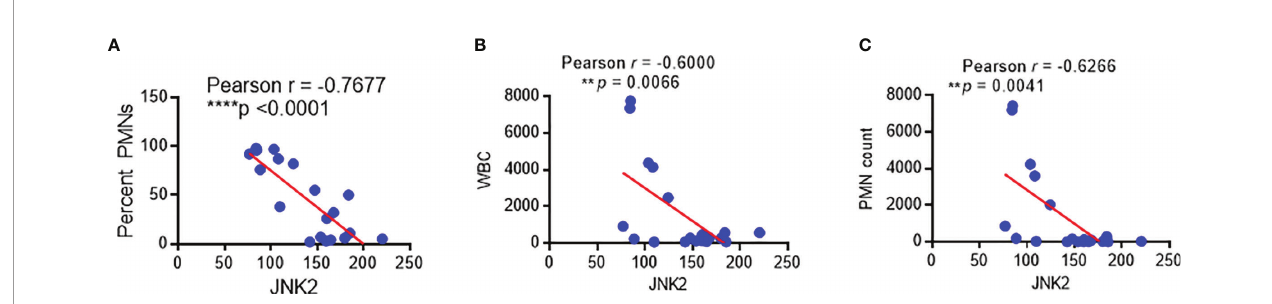
FIGURE 9 | JNK2 levels in alveolar macrophages from patients with pneumonia are inversely correlated with the percentage of neutrophils, neutrophil count, and white blood cell count in the BAL fl uid. Correlation of JNK2 mRNA levels (analyzed by RNA-seq) in AMs with neutrophil percentage (A) , WBC count (B) and neutrophil count (C) in the BAL fl uid of patients with pneumonia. N=20 subjects. ** p < 0.01; **** p